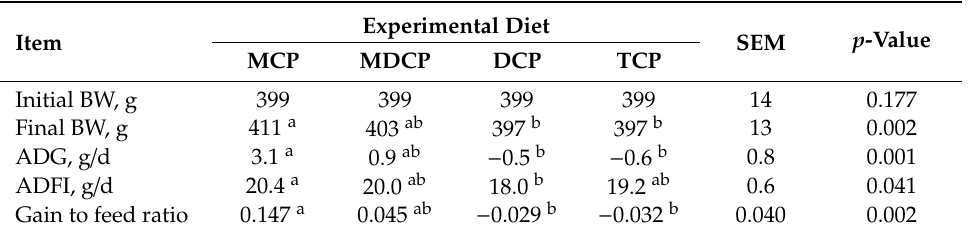
Table 3. Growth performance of broiler chickens fed experimental diets 1 .